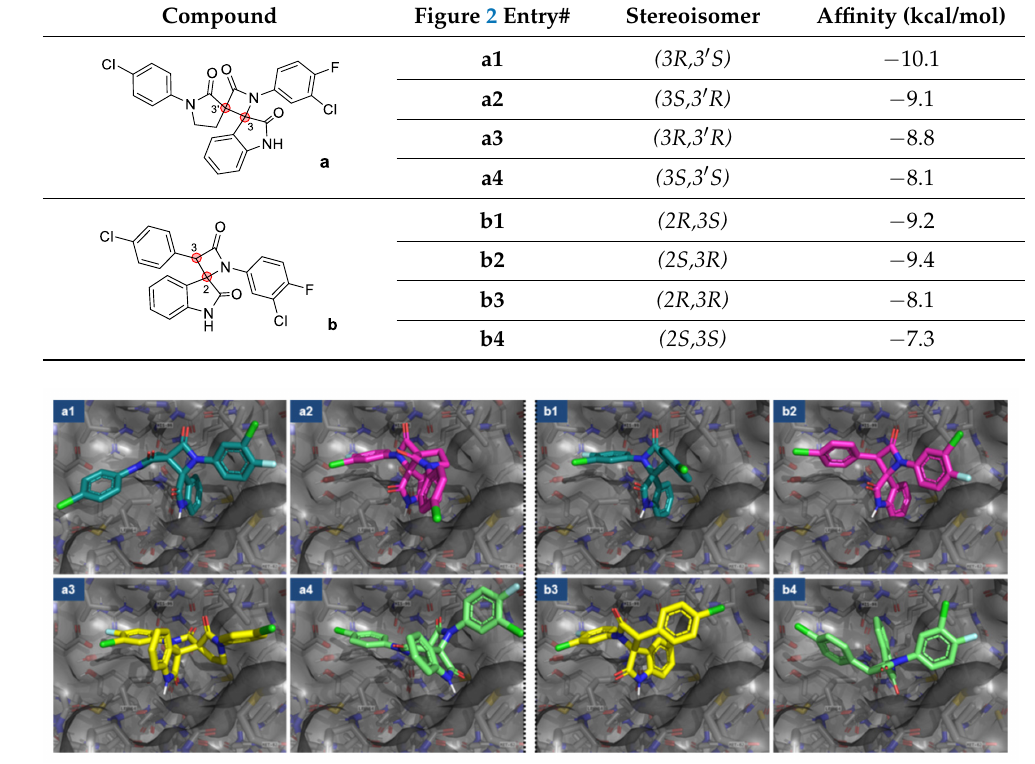
Figure 2. Molecular docking studies of dispiro- ( a ) and spiro- ( b ) indolin-2-ones (see Table 1). Bind- ing modes of four stereoisomers of dispirooxindole- β -lactam ( a1 – a4 ) are compared to isomers of previously studied spirooxindole- β -lactam ( b1 – b4 ) with same-side aryl substituents: ( a1 ) ( 3R, 3′ S ), ( a2 ) ( 3S, 3′ R ), ( a3 ) ( 3R, 3′ R ), ( a4 ) ( 3S, 3′ S ); ( b1 ) ( 2R,3S ), ( b2 ) ( 2S,3R ), ( b3 ) ( 2R,3R ), ( b4 ) ( 2S,3S ). Table 1. Affinity energy comparison of dispirooxindole ( a ) and the previously described [27] spirooxindole- β -lactam ( b ). Figure 2 Compound Entry# Stereoisomer